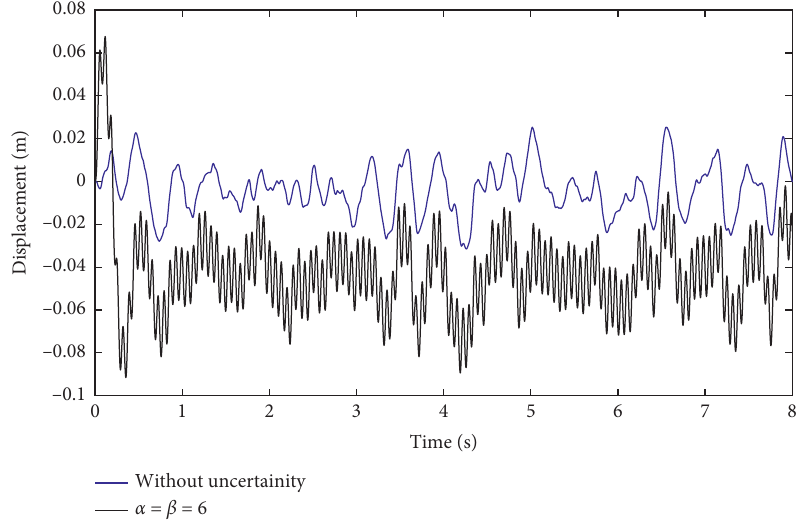
Without uncertainity Figure 12: Uncontrolled system behavior in the presence of system